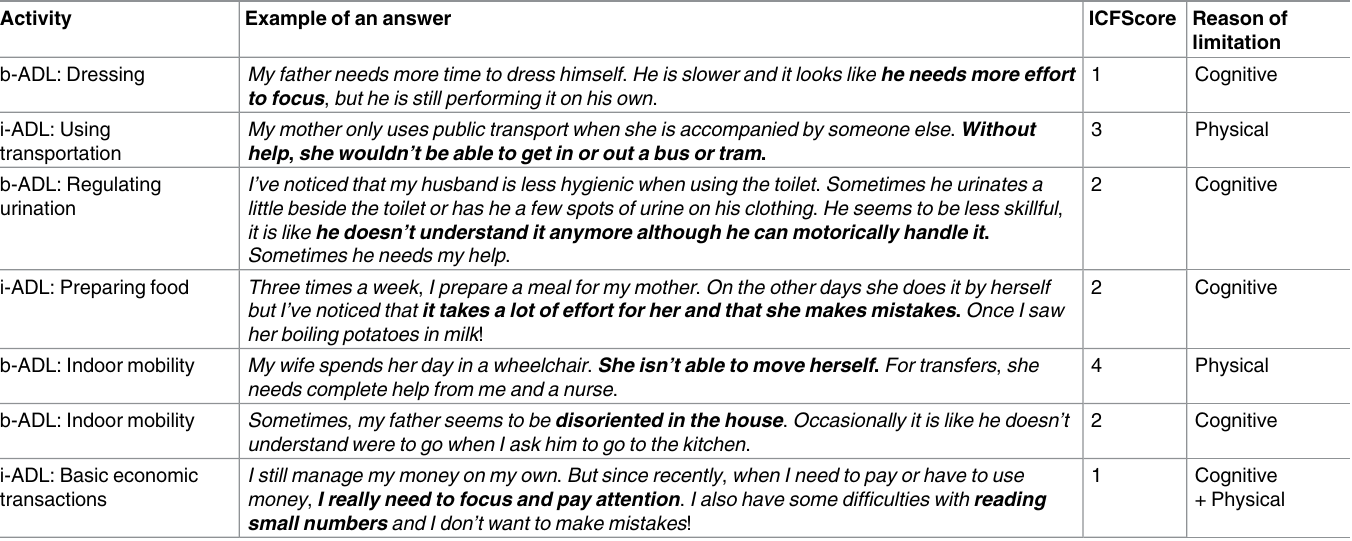
Table 4. Examples of ICF scores and physical or cognitive reasons of limitations. Activity Example of an